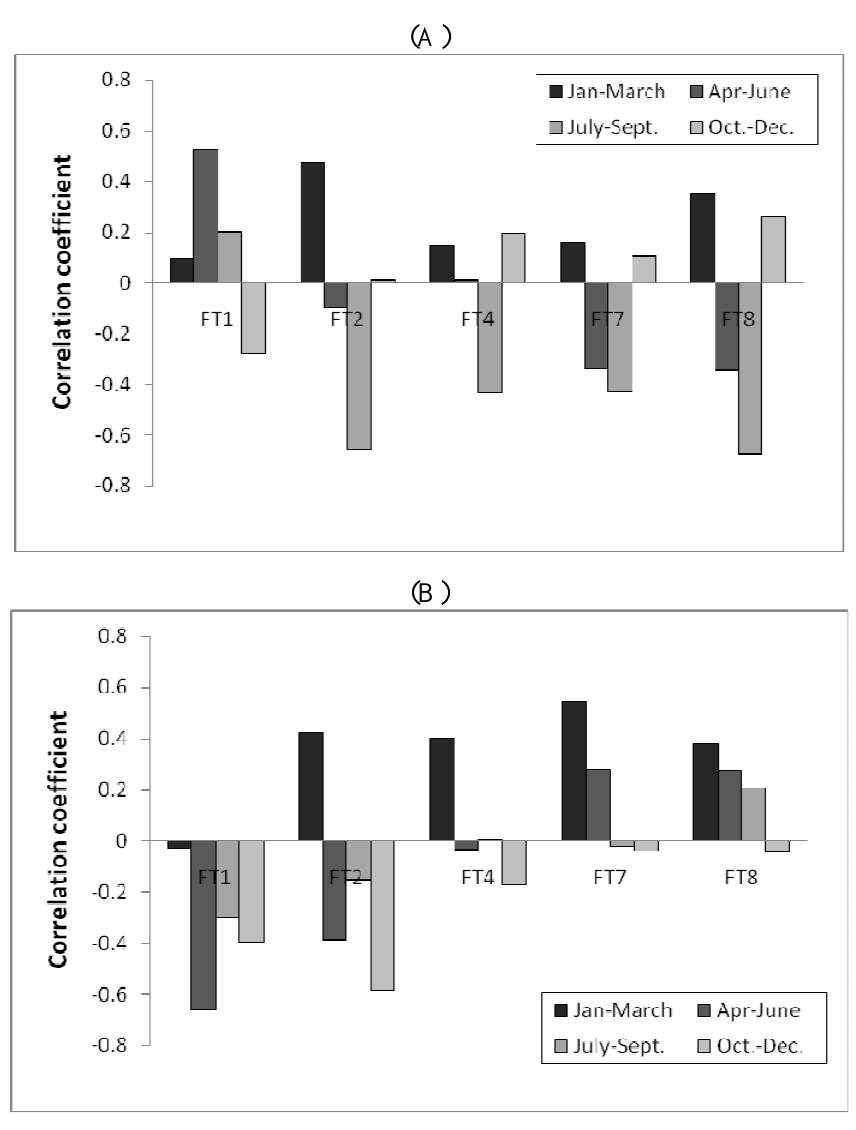
Figure 4. Correlation coefficients found for the five forest types between annual GPP estimated by Modified C-Fix and seasonal temperatures (A) and rainfall (B).